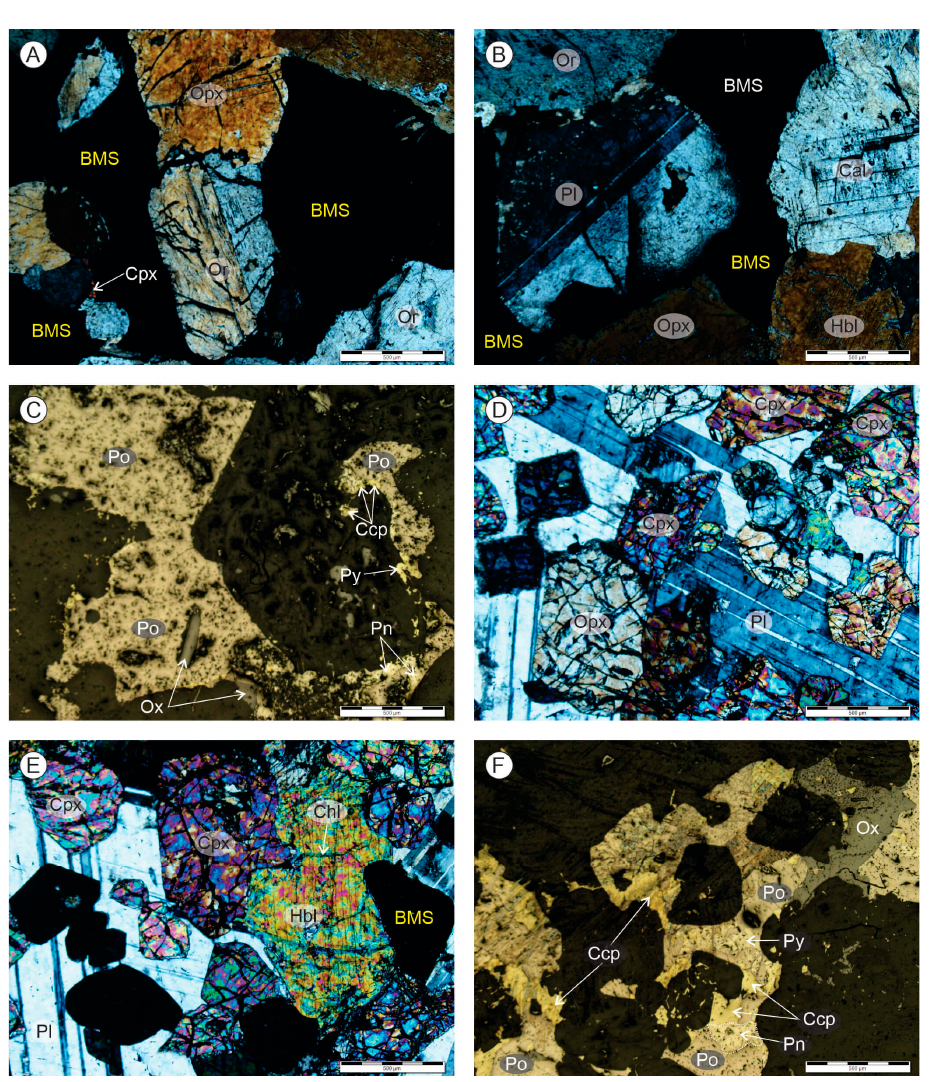
Figure 6. Photomicrographs of the high-grade net-texture ore ( A – C ) and medium-grade net-texture ore ( D – F ) showing various silicate and sulfide minerals. The scale bar at the bottom right corner of the images represents 500 µm. Refer to Figure 2 for explanation of the mineral abbreviations. Table 3. Microscopic (petrographic) description of the PCMZ ores.